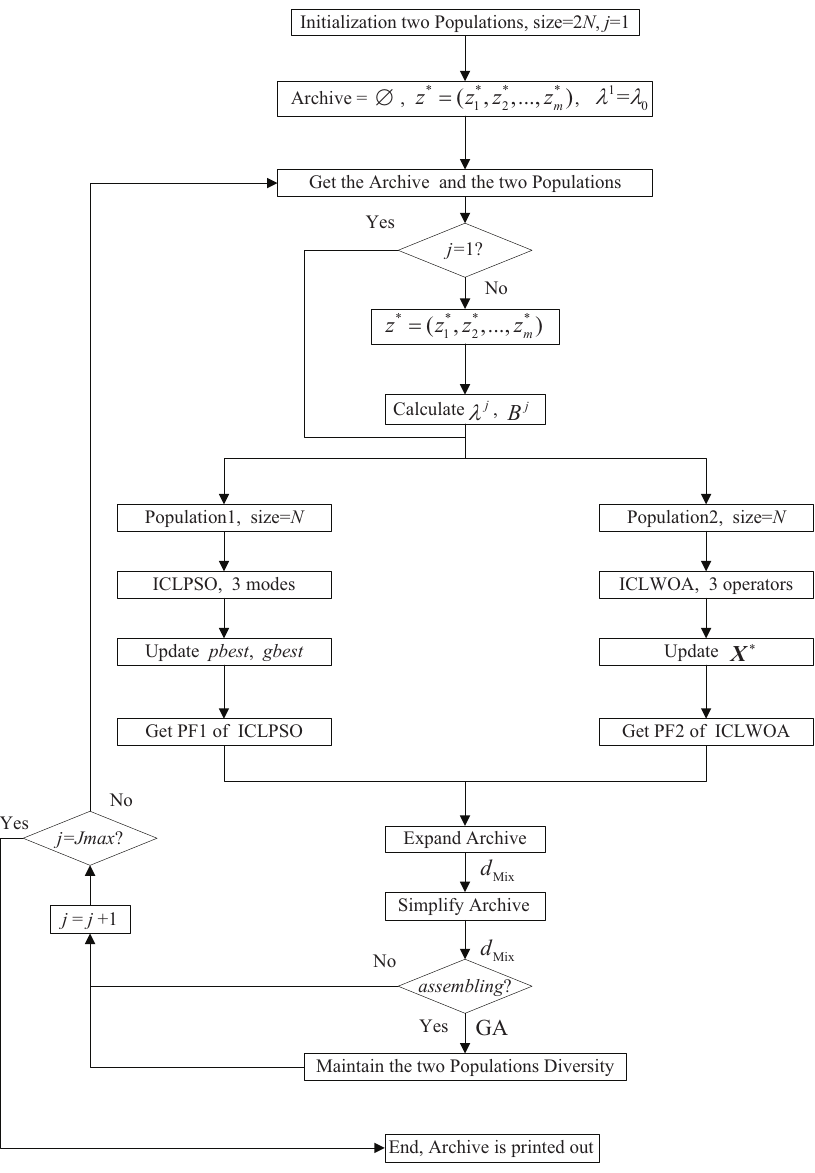
Figure 8. Flow chart of improved multi-objective hybrid optimization algorithm using a comprehensive learning strategy